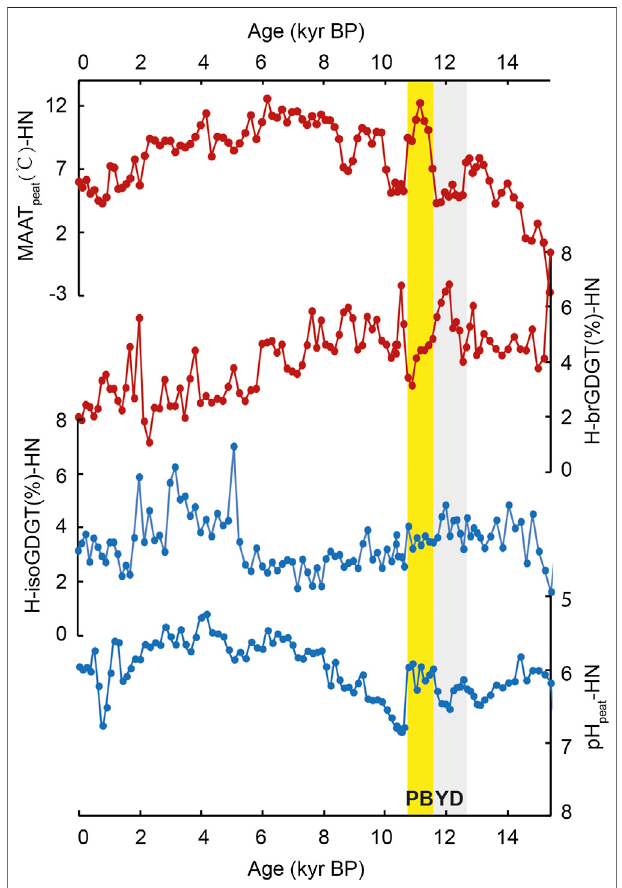
FIGURE 2 | Comparison of the abundance of both H-isoGDGTs and H-brGDGTs ( Eqs 1 and 2 , respectively), mean annual air temperature (MAAT peat ) and pH peat in Hani peat. YD and PB are known as the Younger Dryas (YD) and the Preboreal, highlighted by the gray and yellow box, respectively (the depicted period is approximate).